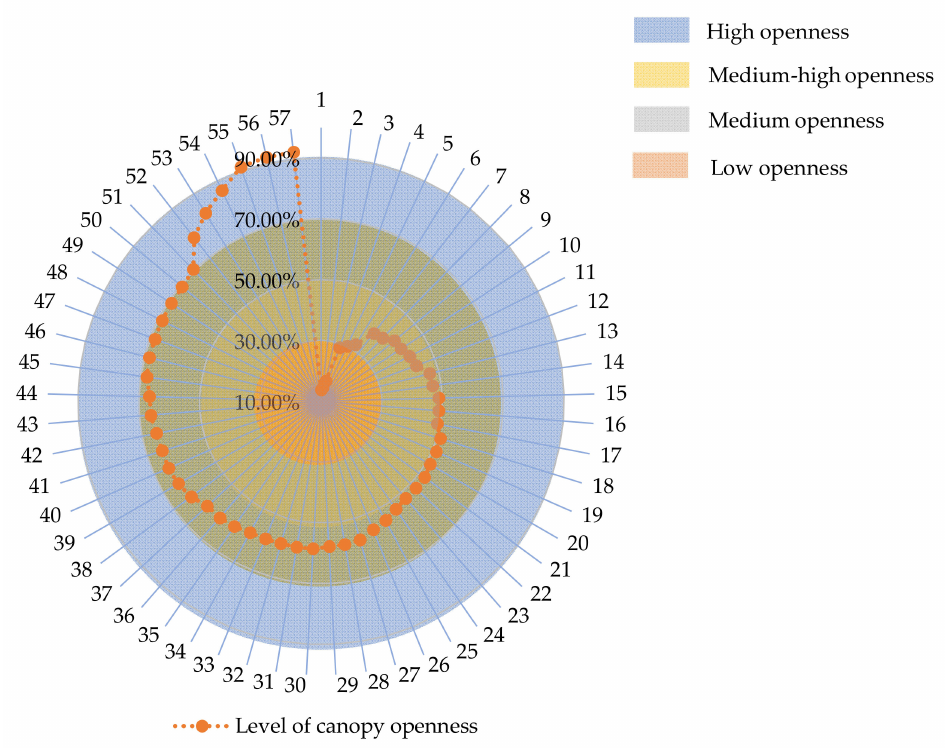
Figure 4. Test points openness and